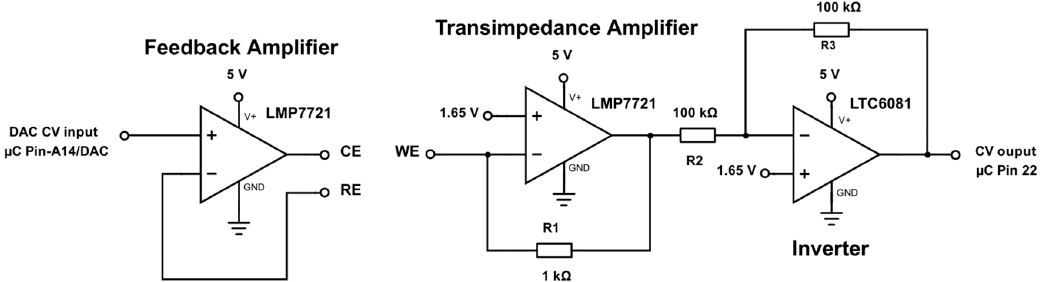
Figure 15. Circuit schematic showing a basic potentiostat setup for cyclic voltammetry interfacing to the WE, CE and RE.